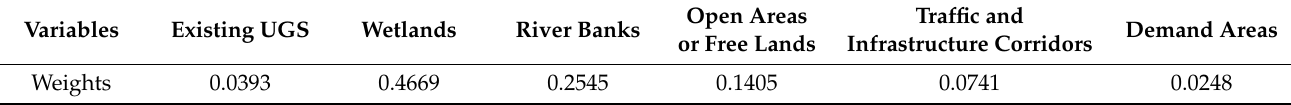
Table 2. Adaptability variables and their